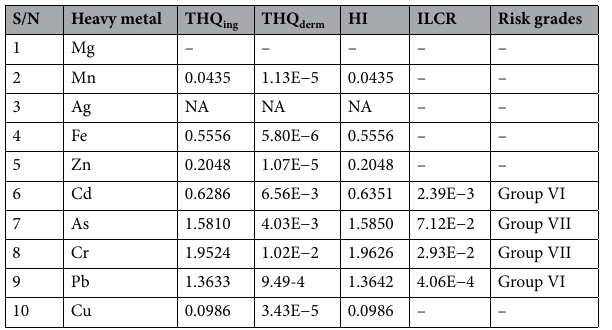
Table 14. Estimated mean HI and ILCR of the heavy metals in water samples collected within the study site.